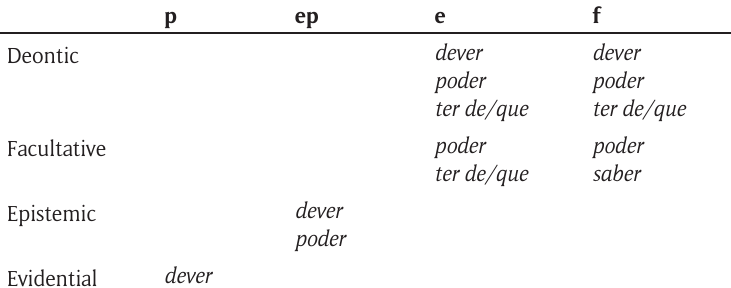
Table 8: The distribution of modal verbs.